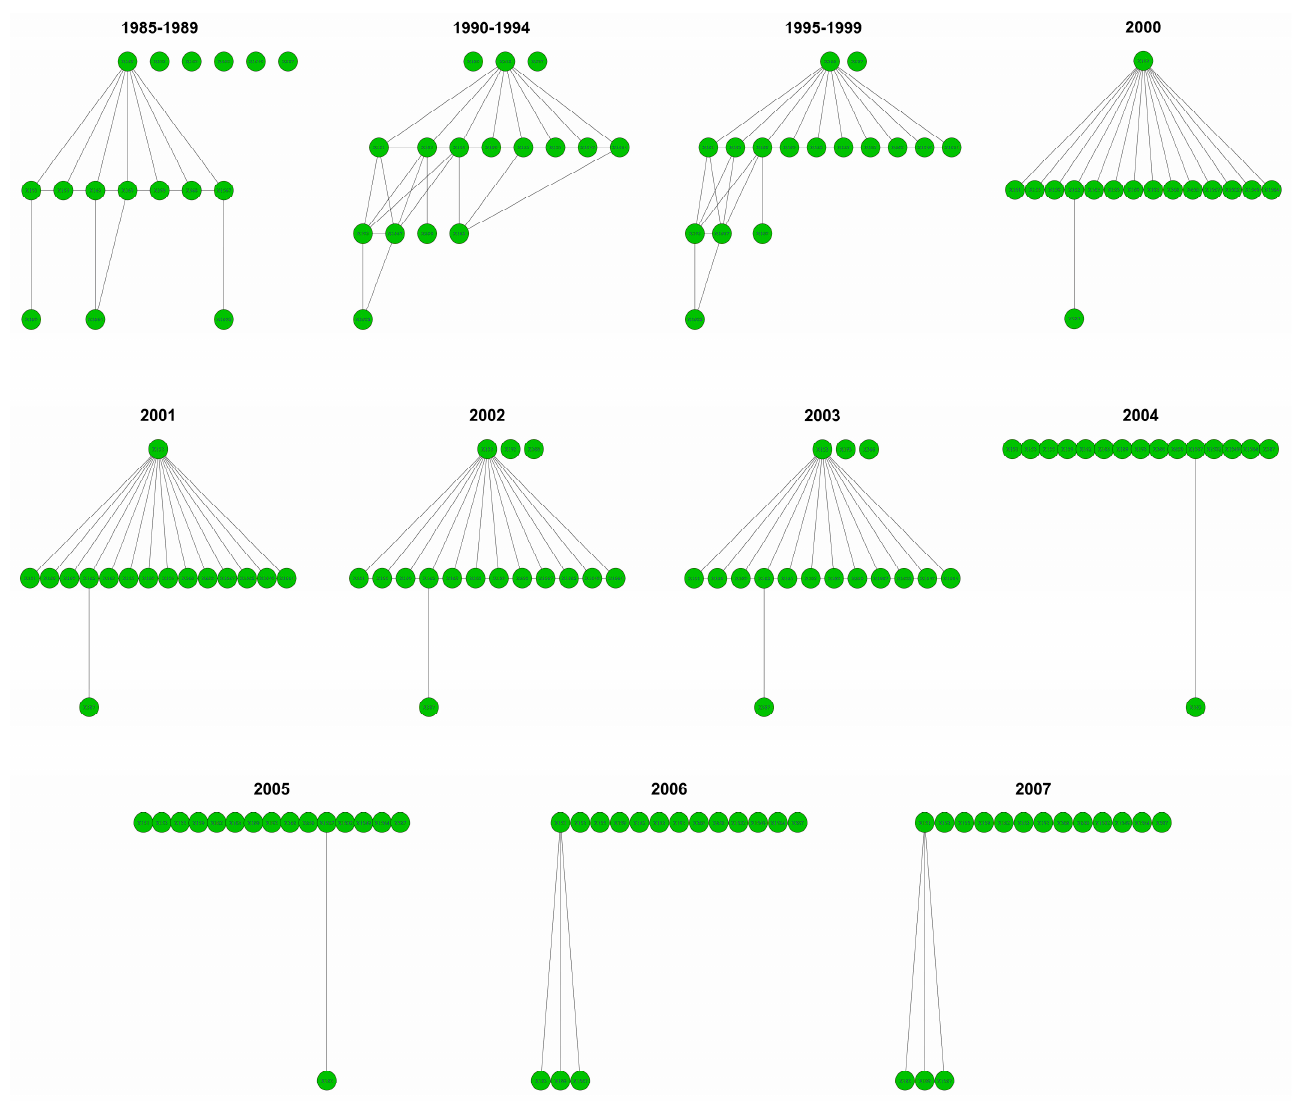
Figure 4. Temporal development of the hierarchical structure of “Jamaah Islamiah section of Phil- ippines”. We observe a change of centralization during 2000–2003.